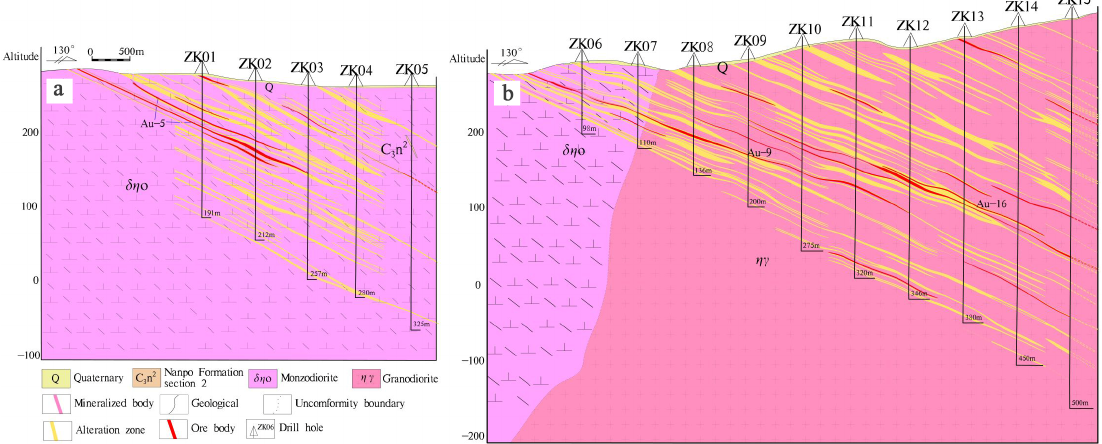
Figure 7. Prospecting profile of the drill hole verifying the anomalies, showing the revealed Au mineralization in the Nanpo deposit: ( a ) 111 line borehole profile; ( b ) 191 line borehole profile.